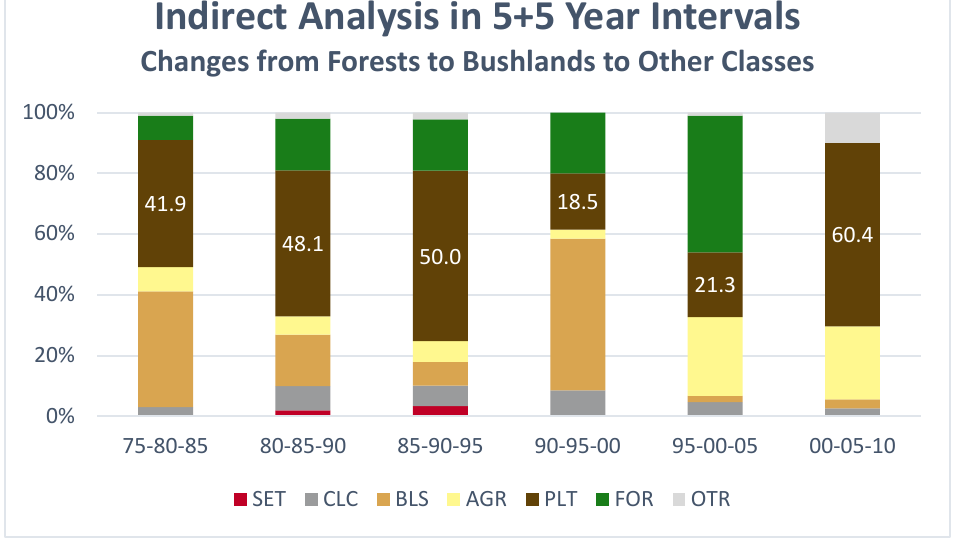
Figure 7. Indirect analysis in five plus five-year intervals. Analysis shows the percentage of forests converted into the first five-year interval and the final land use system after 10 years.